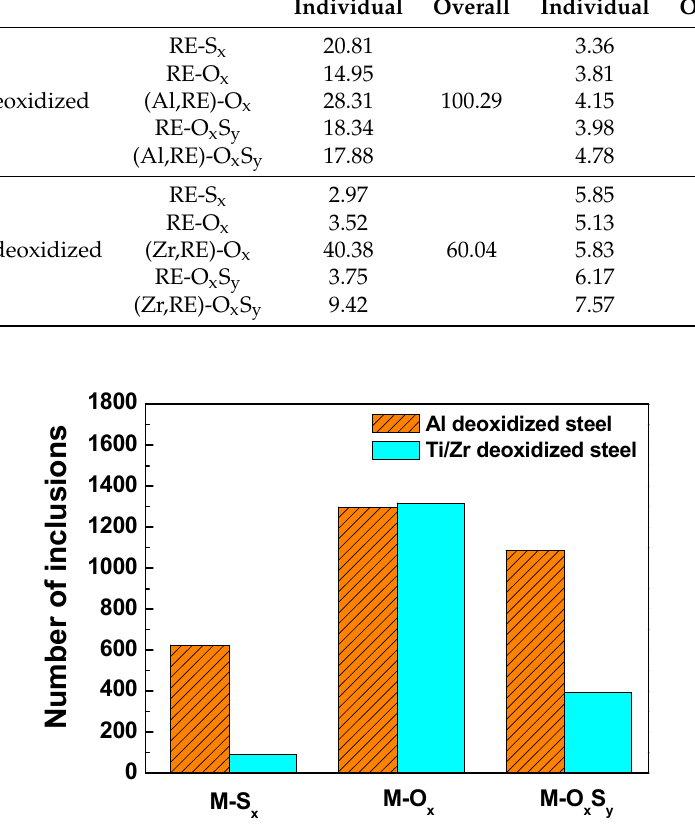
Figure 4. Number distributions of different kinds of inclusions in Al deoxidized steel and Ti/Zr deoxidized steel in a 30 mm 2 scanning region.